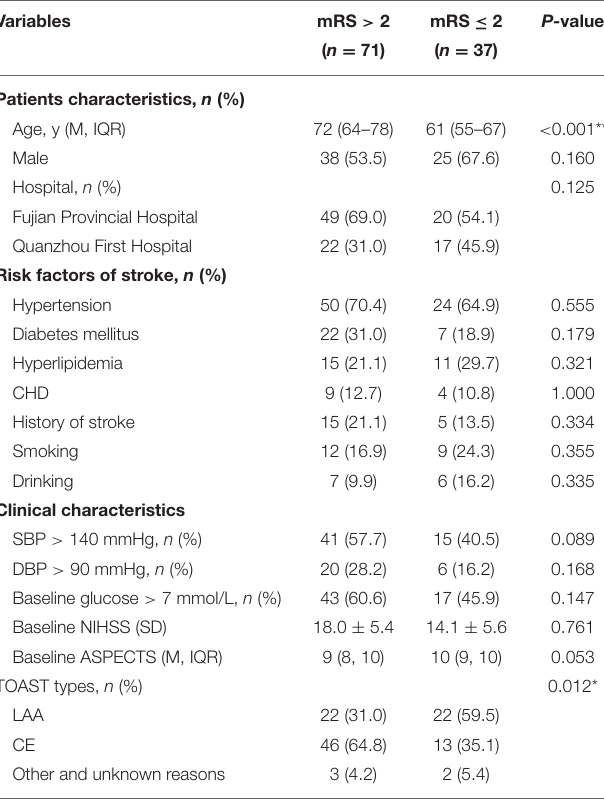
TABLE 1 | The baseline clinical data of patients with and without a favorable outcome. Variables